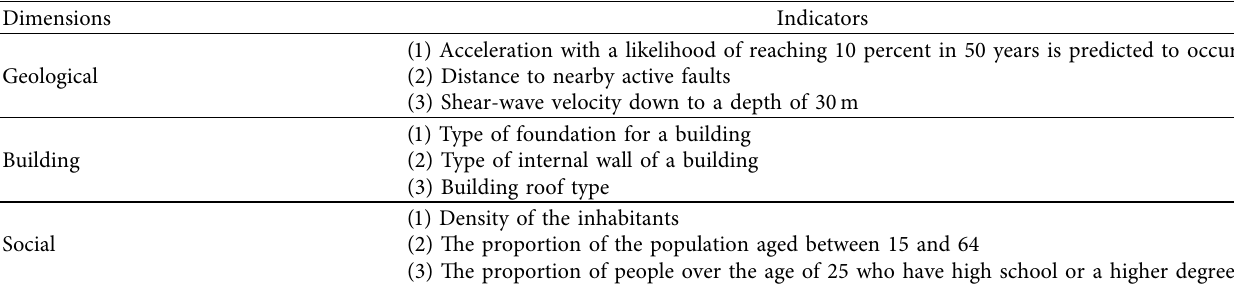
Table 2: Summarizing the indicators for each dimension